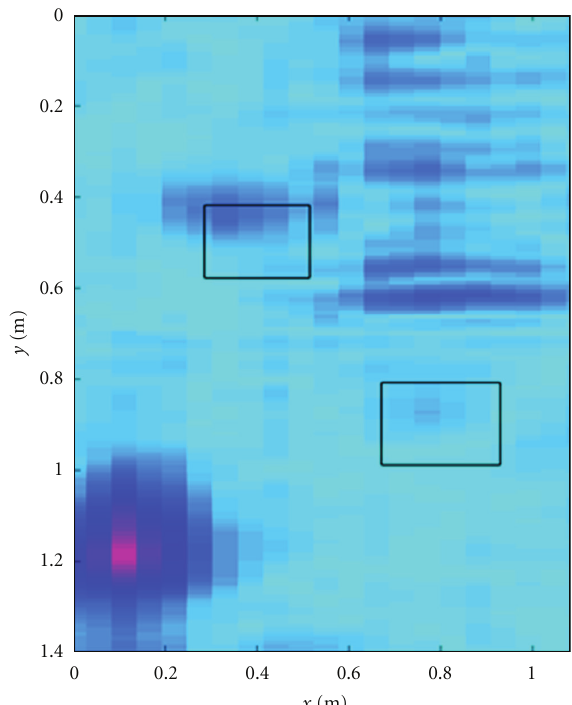
Figure 6: Constant depth slice at the depth of about 40cm, achieved from inversion.